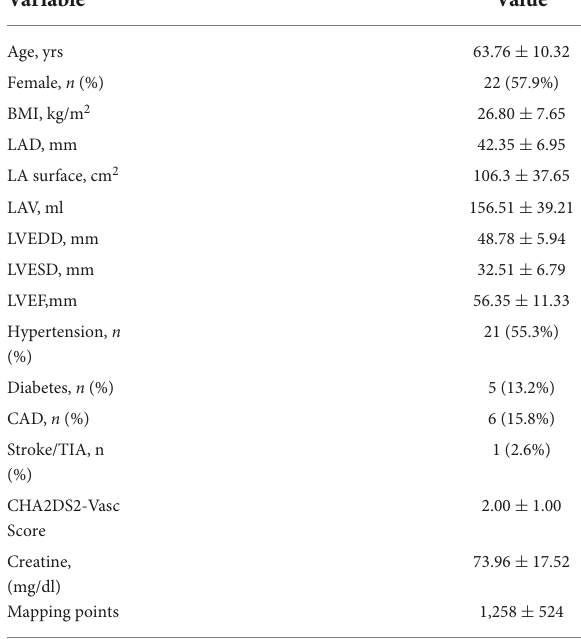
TABLE 1 Baseline characteristics of the study group ( n =